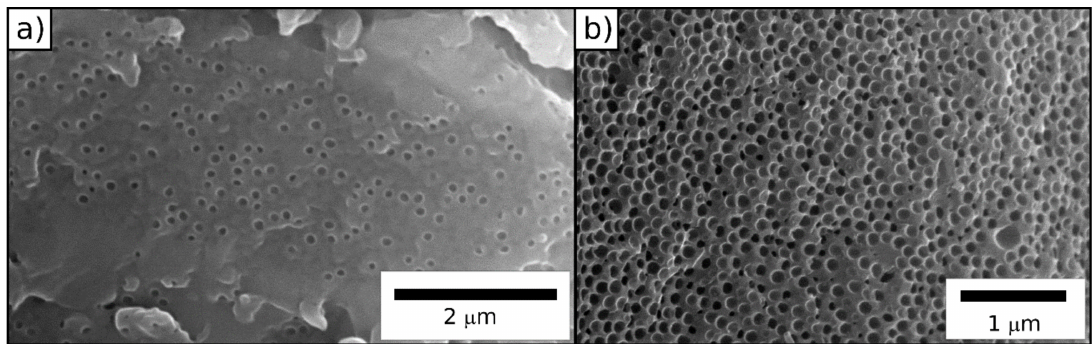
Figure 11. Mass loss of the colloidal crystal made of particles from ATRP during the thermal treatment.